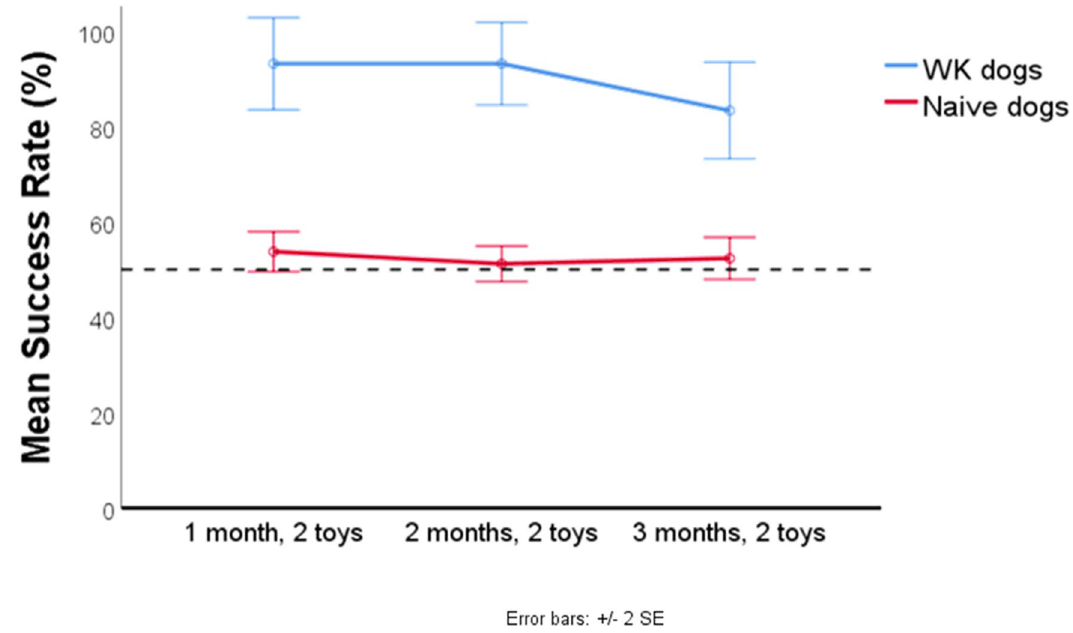
Figure 1. The bar plot shows the overall mean (± SE) success across the 3-months tests of the naïve dogs , puppies and adults (first month N = 34, second month N = 33, third month N = 32) and WK dogs (N = 6) tested on the two trained toy names in two-way choice tests. Dotted line represents chance level